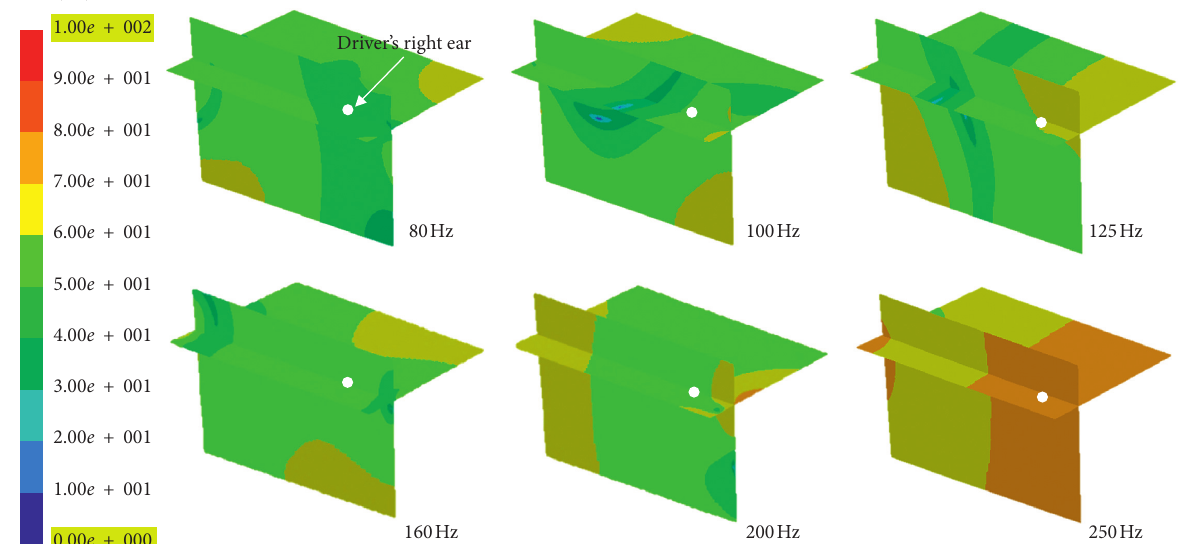
Figure 10: The distribution of the OSRVM A sound pressure level at the field point in the